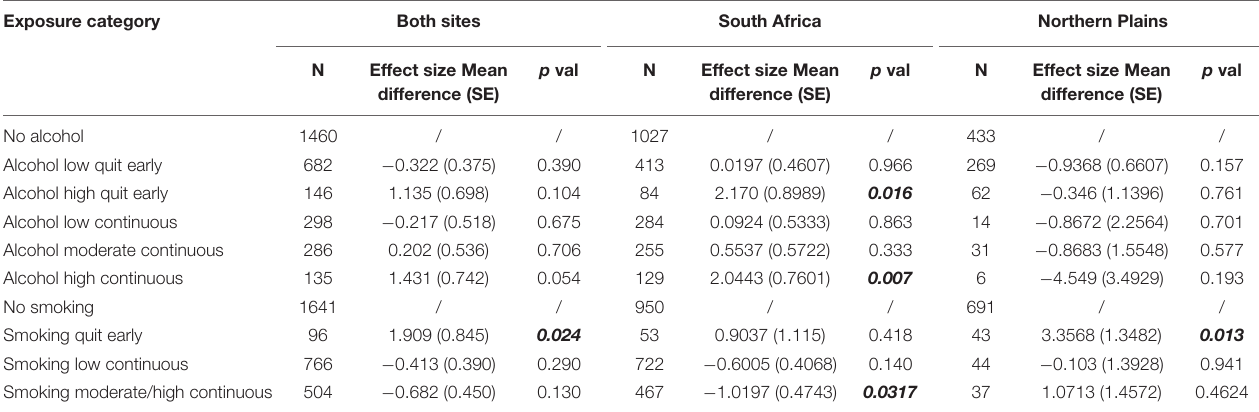
TABLE 5 | Linear regression results from alcohol and smoking exposure predicting Mean HR in 1F.